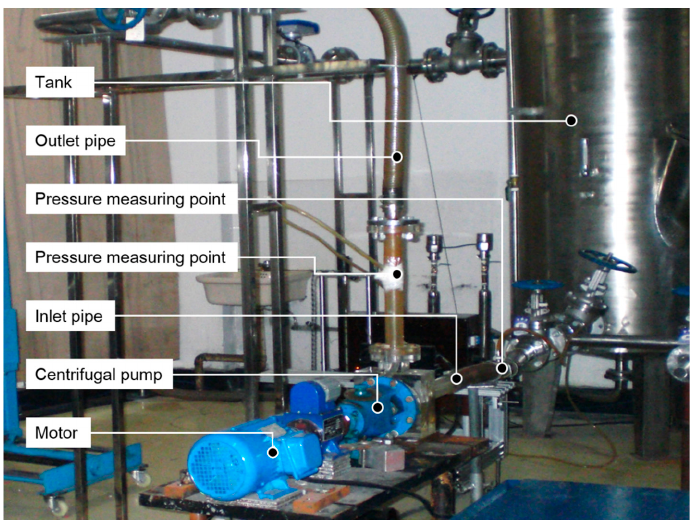
Figure 4. The scheme of the test rig.